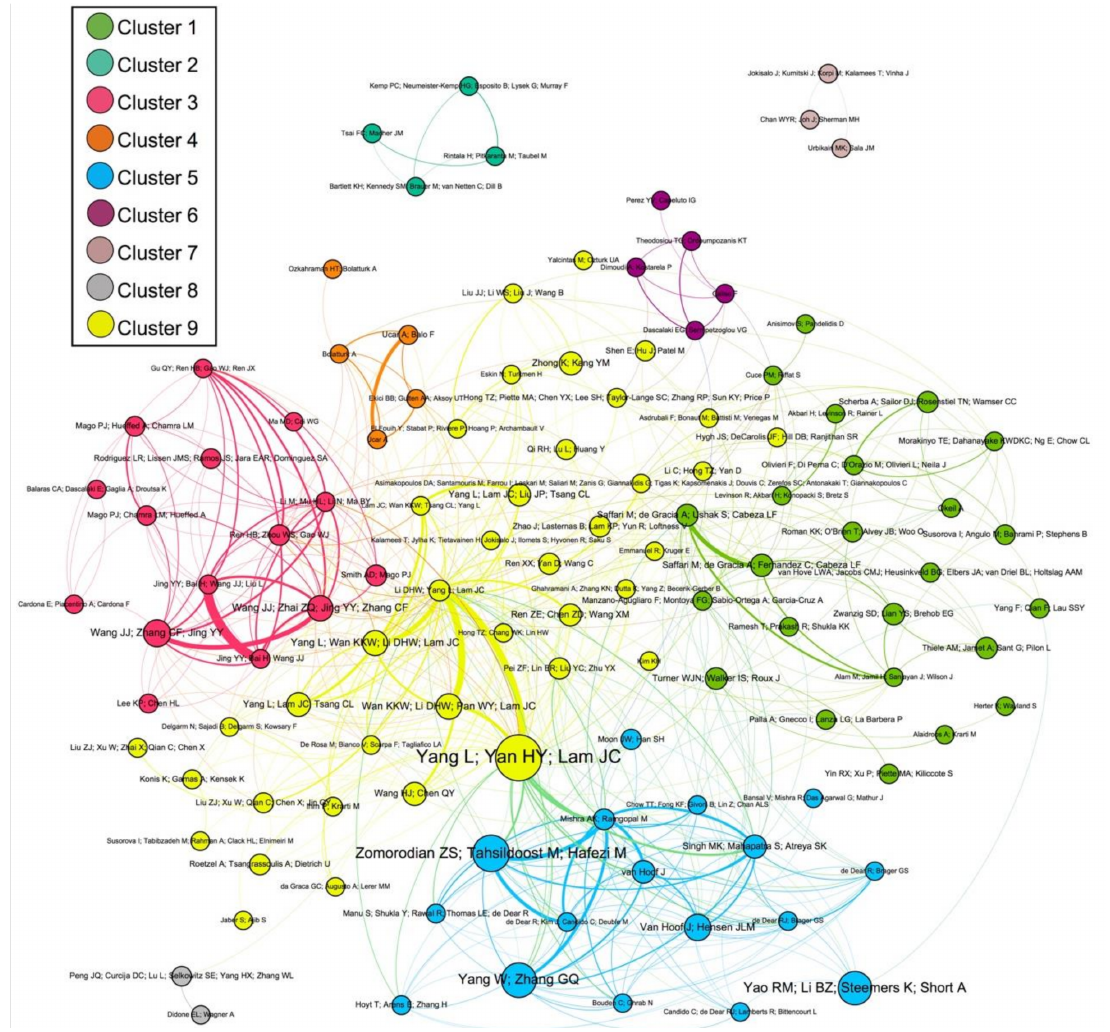
Figure 4. Map of bibliographic coupling